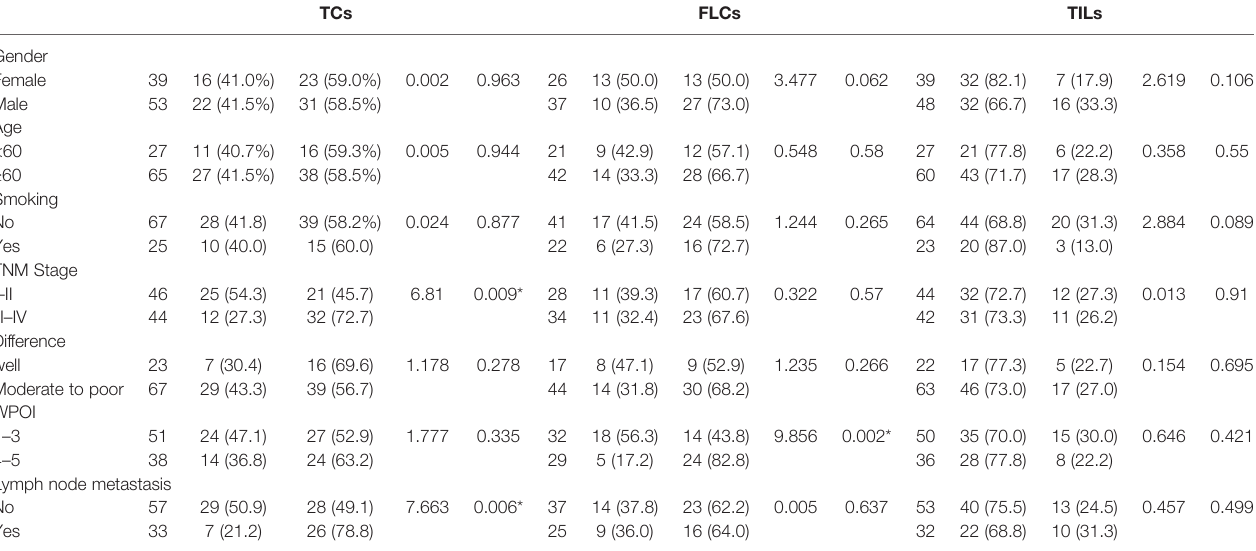
TABLE 1 | Association between CD38 expression and clinicopathological characteristics in OSCC patients. TCs FLCs Gender